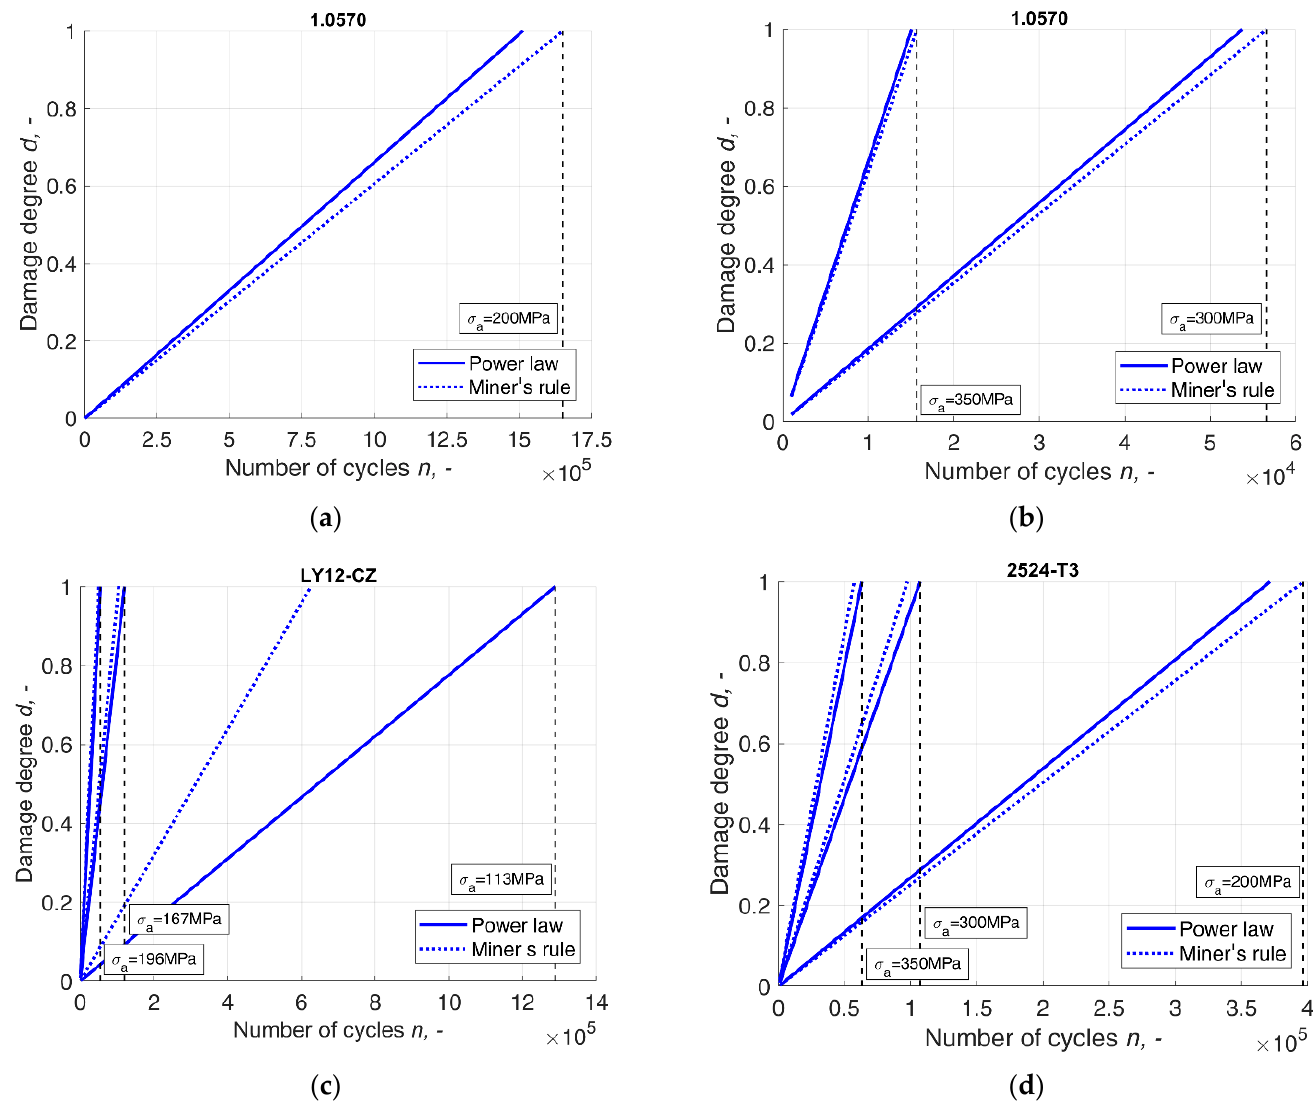
Figure 5. Differences between the Miner’s damage degree and the degree of damage calculated according to the proposed model, where ( a , b ) 1.0570 steel. ( c ) LY12-CZ aluminium alloy; ( d ) 2524-T3 aluminium alloy.